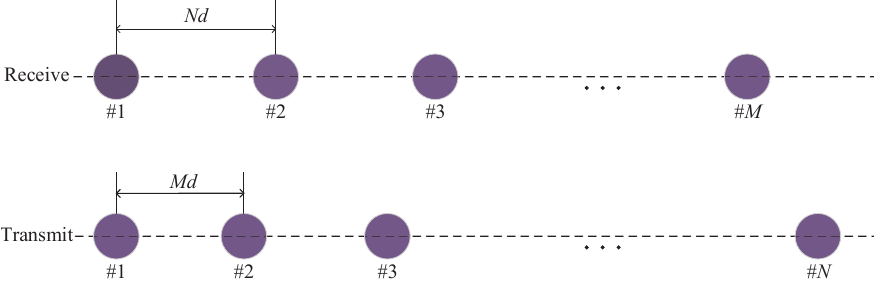
Figure 1. Configuration of the coprime FDA under